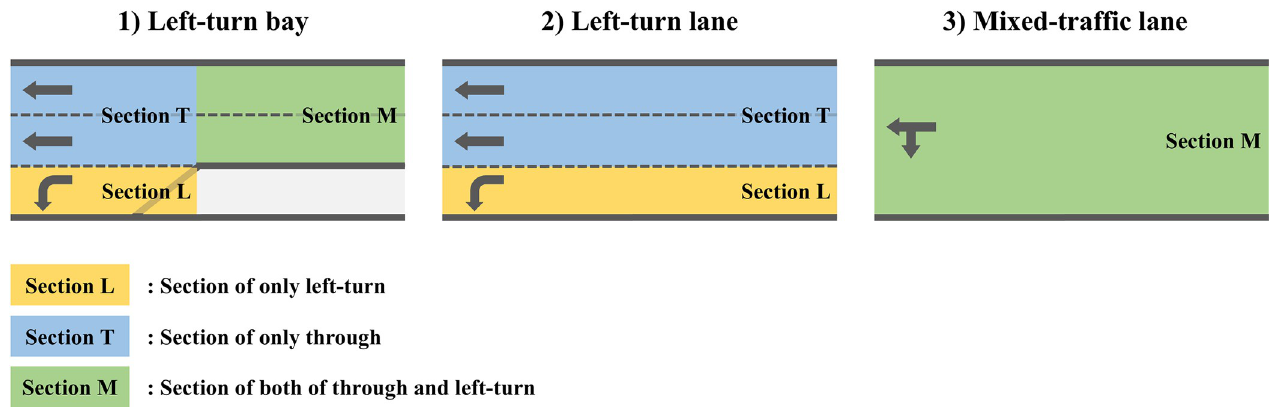
Fig 3. Section division based on lane structure.